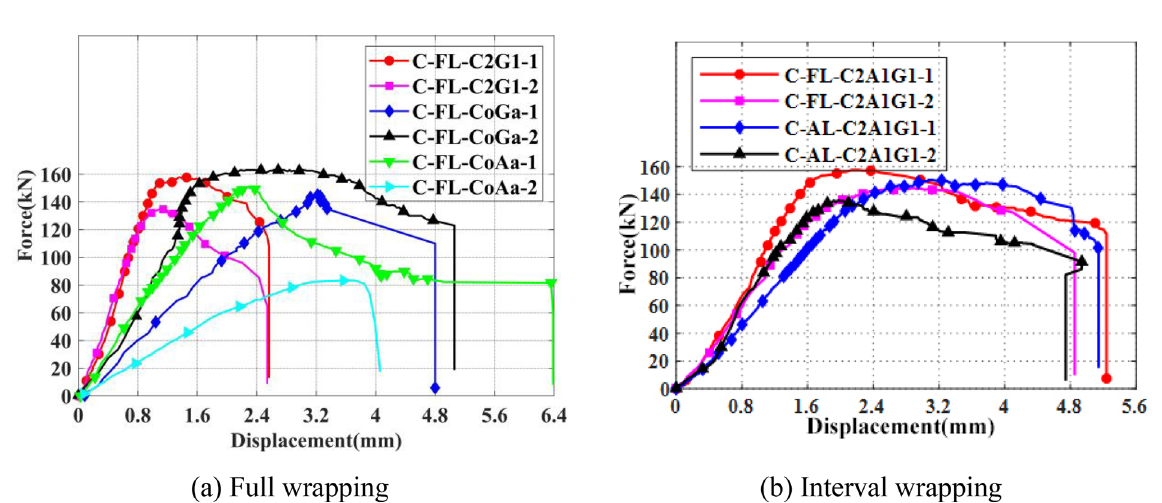
Fig. 13 Load–displacement curve of group